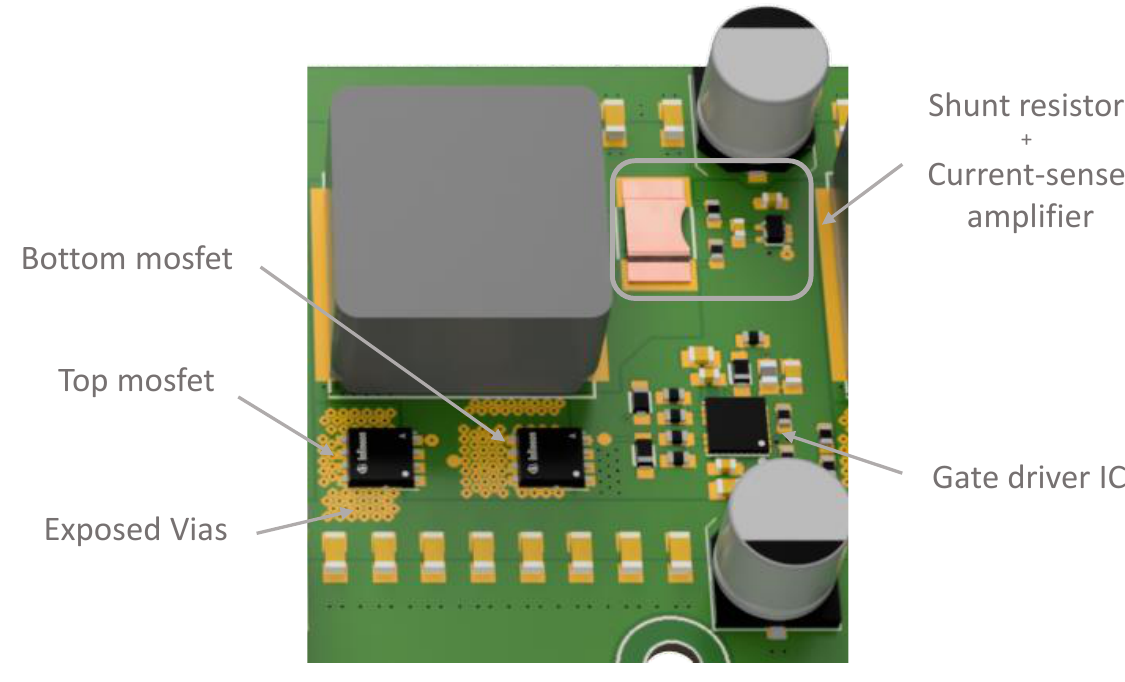
Figure 7. Detail of one phase on the